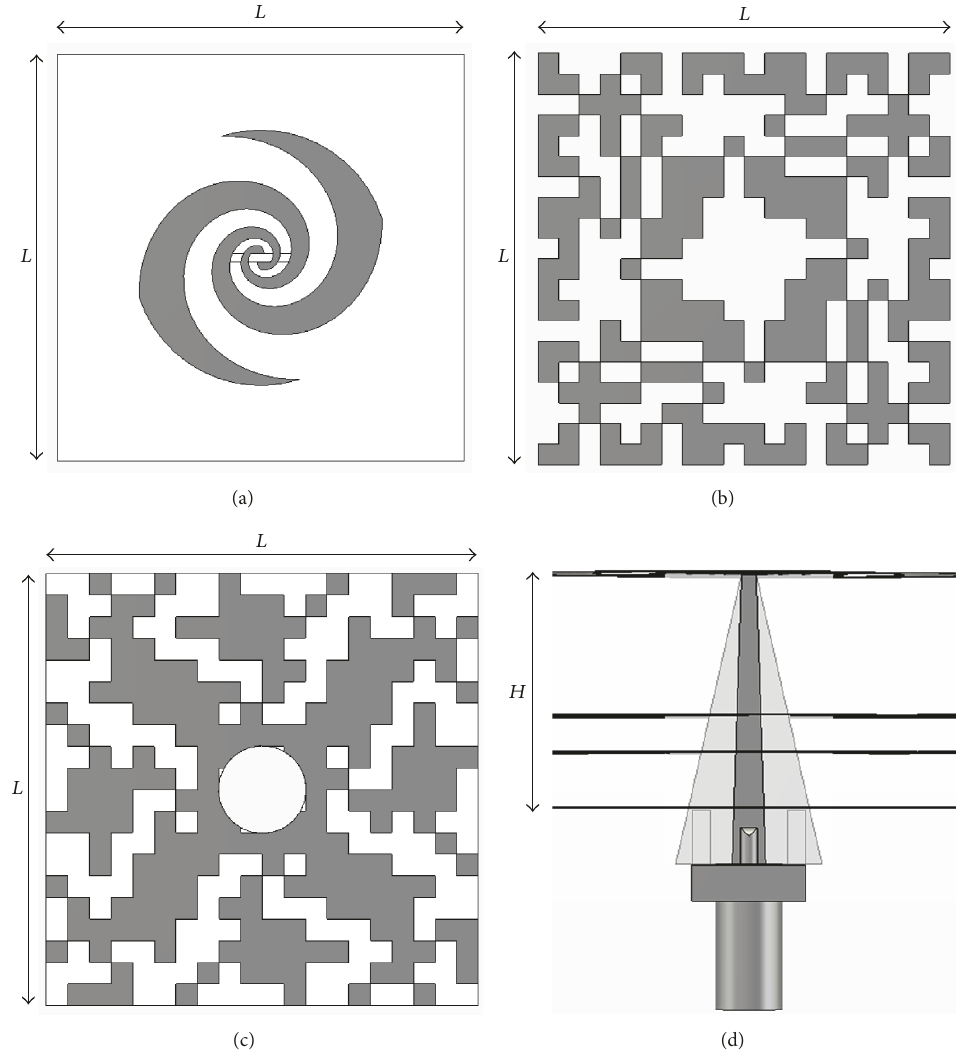
Figure 4: Antenna structure: (a) equiangular spiral antenna, (b) parasitic layer 1, (c) parasitic layer 2, and (d) side view and balun.